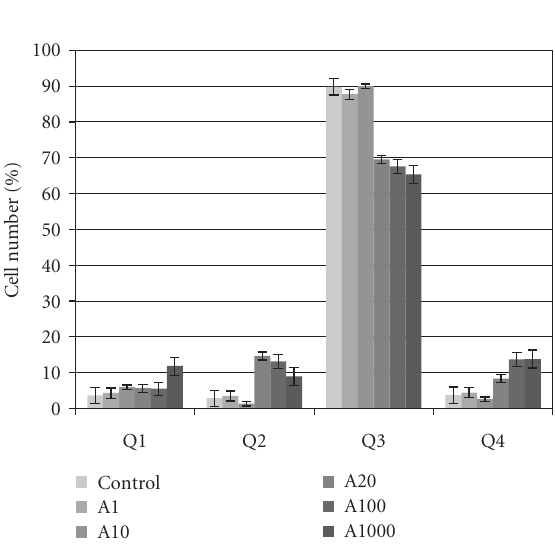
Figure 2: E ff ects of aspirin on cell cycle kinetics of MG-63 cell line determined by flow cytometry. Cultured cells were treated for 24h with 1, 10, 20, 100, or 1000 μ M aspirin. Control group was not treated. G0/G1, S, and G2/M represent the percentage of cells distributed among these phases after treatment, as determined by flow cytometry. We repeated experiments at least three times.